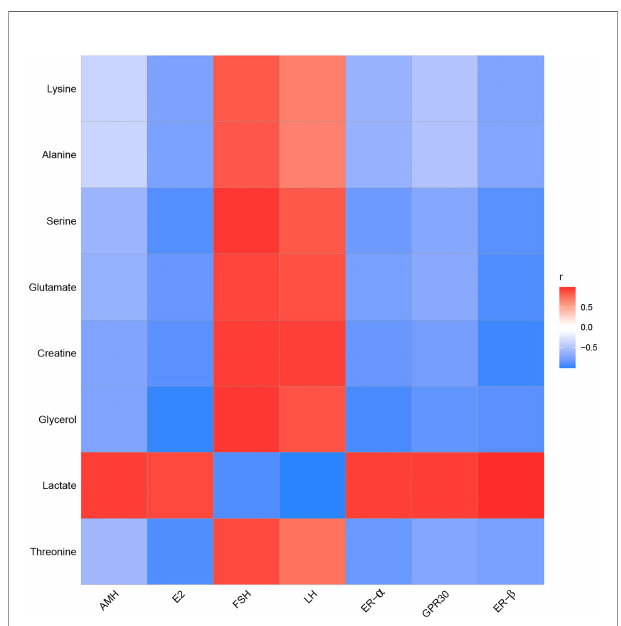
FIGURE 12 | The correlation analysis between POF and characteristic metabolites in the